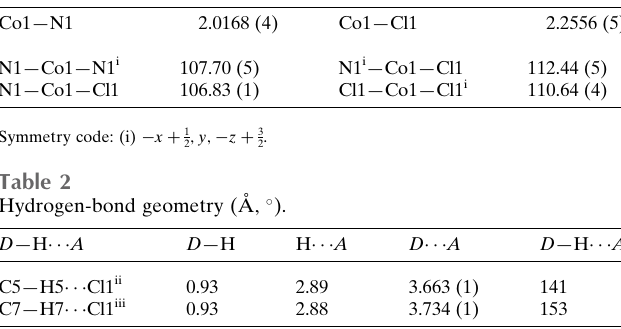
Table 1 Selected geometric parameters (A˚ , (cid:3) ).